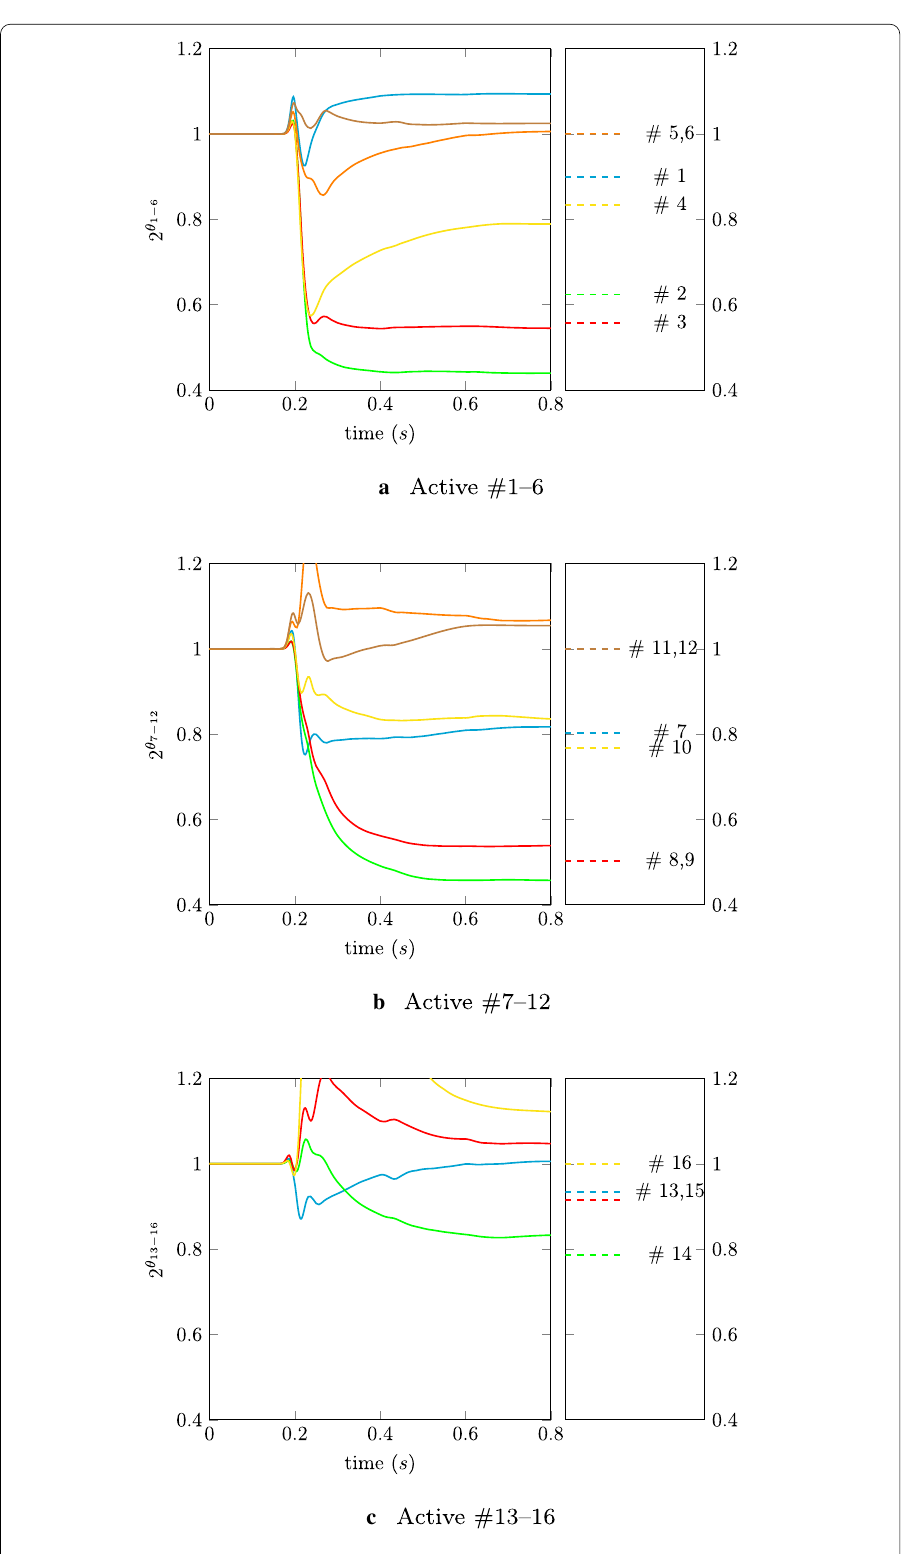
Fig. 17 Time evolution of active estimated parameters using tag planes with coarse time sampling of the observations (dashed lines give reference